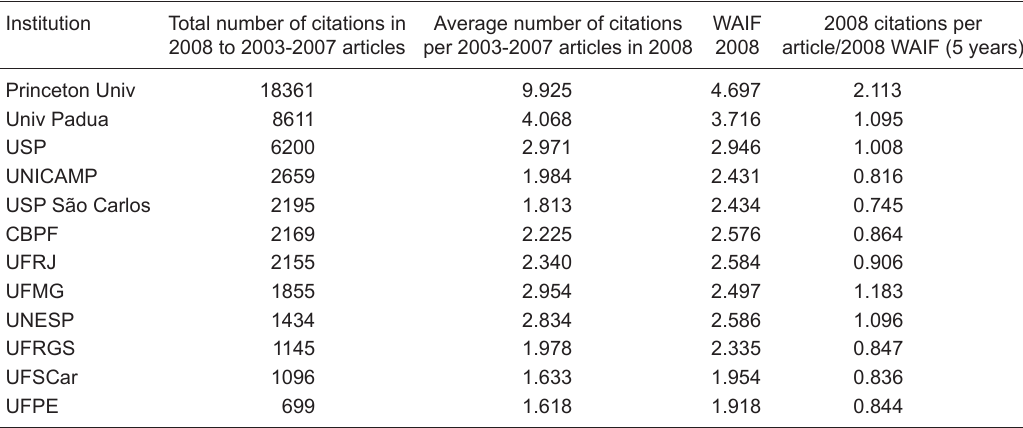
Table 1. Scientometric indicators of Brazilian institutions of physics.